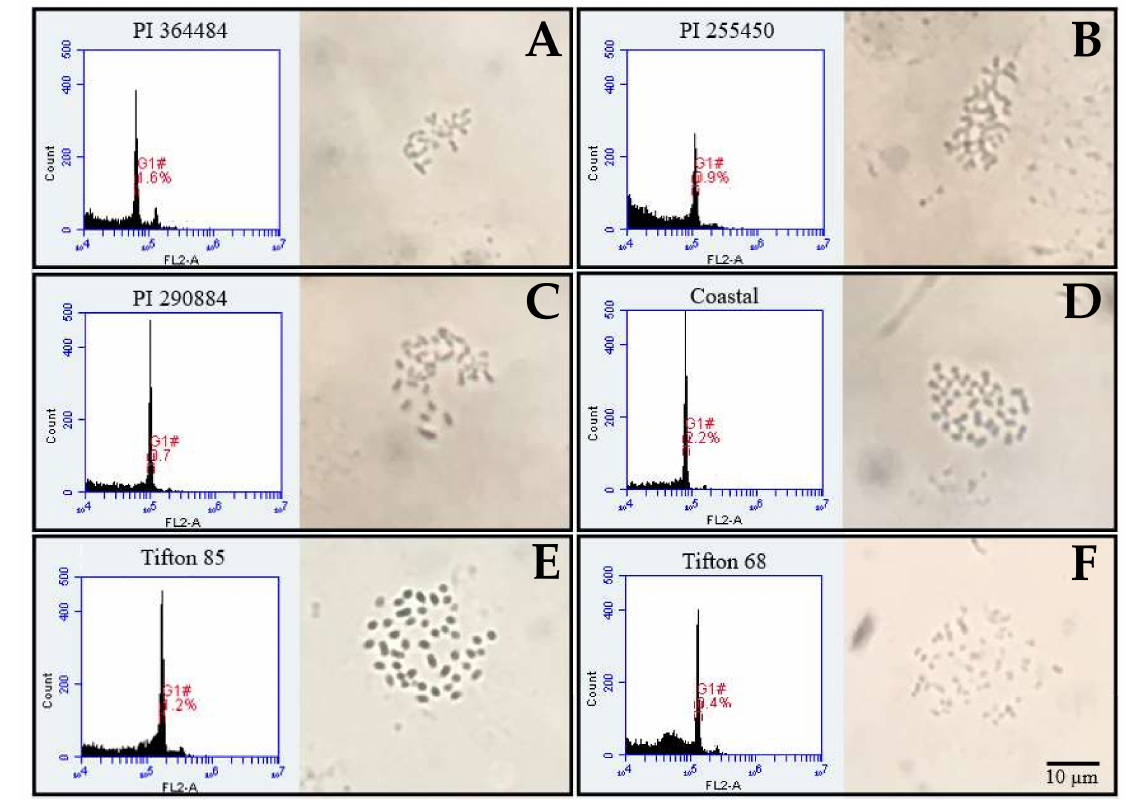
Figure 2. Histograms showing fluorescence intensity of propidium iodide bound to DNA in cell nuclei ( left ) and root tips exhibiting chromosomes under 400x magnification for six bermudagrass genotypes ( right ). Flow cytometry histograms depict the propidium iodide florescence area signals (FL2A) of the sample nucleic DNA in the x -axis, and the number of nuclei in the y -axis. G1 peaks (red) were gated to indicate the cells in the G1 stage of the cell cycle. The genotypes are showing increasing ploidy levels: ( A ). 2n = 2x = 18, PI 364484; ( B ). 2n = 3x = 27, PI 255450; ( C ). 2n = 4x = 36, PI 290884; ( D ).